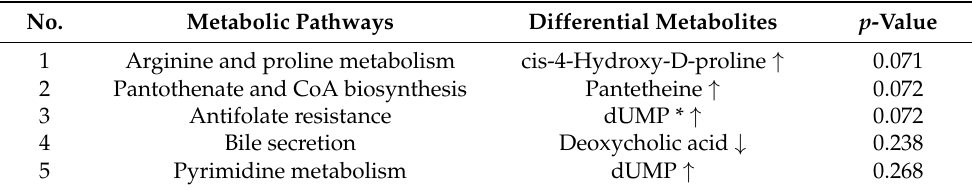
Table 7. A comparison of the concentrations of metabolites in pancreas tissue from yak calves fed alfalfa and oat hay or oat hay.